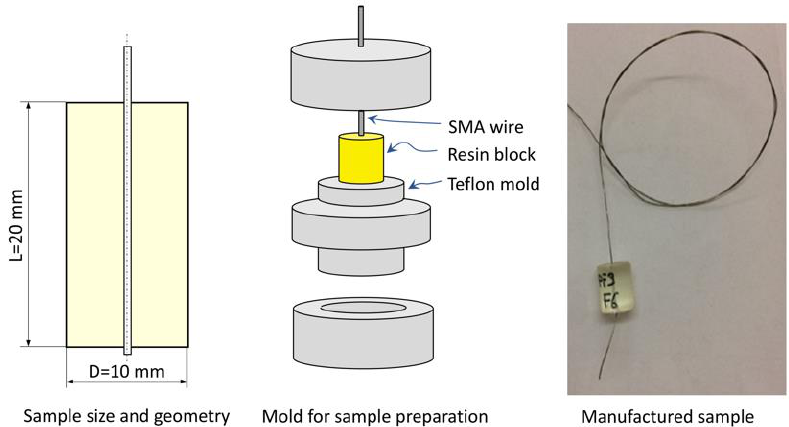
Figure 4. SMA – polymer sample for pullout tests: size, geometry and schematic of the manufacturing